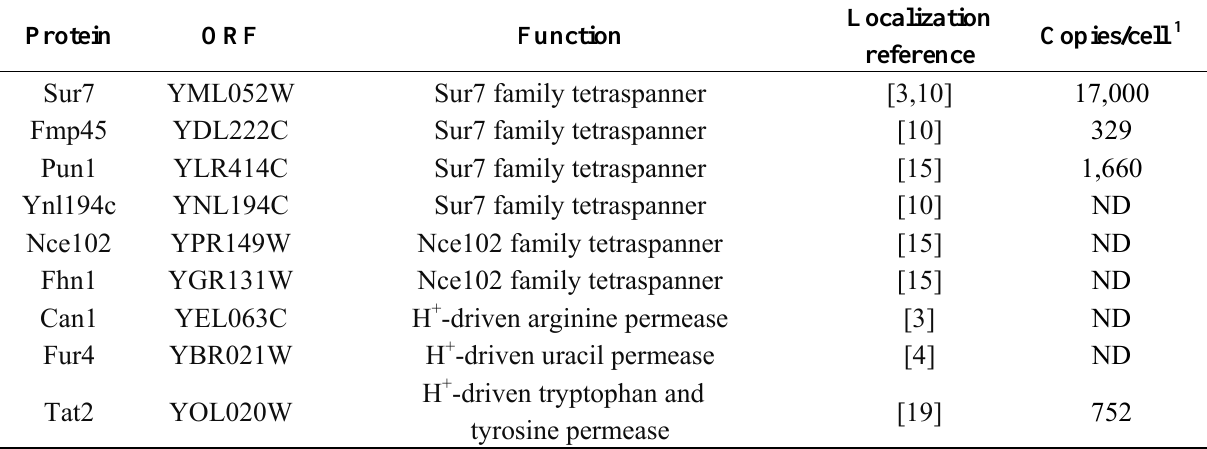
Table 1. S. cerevisiae MCC